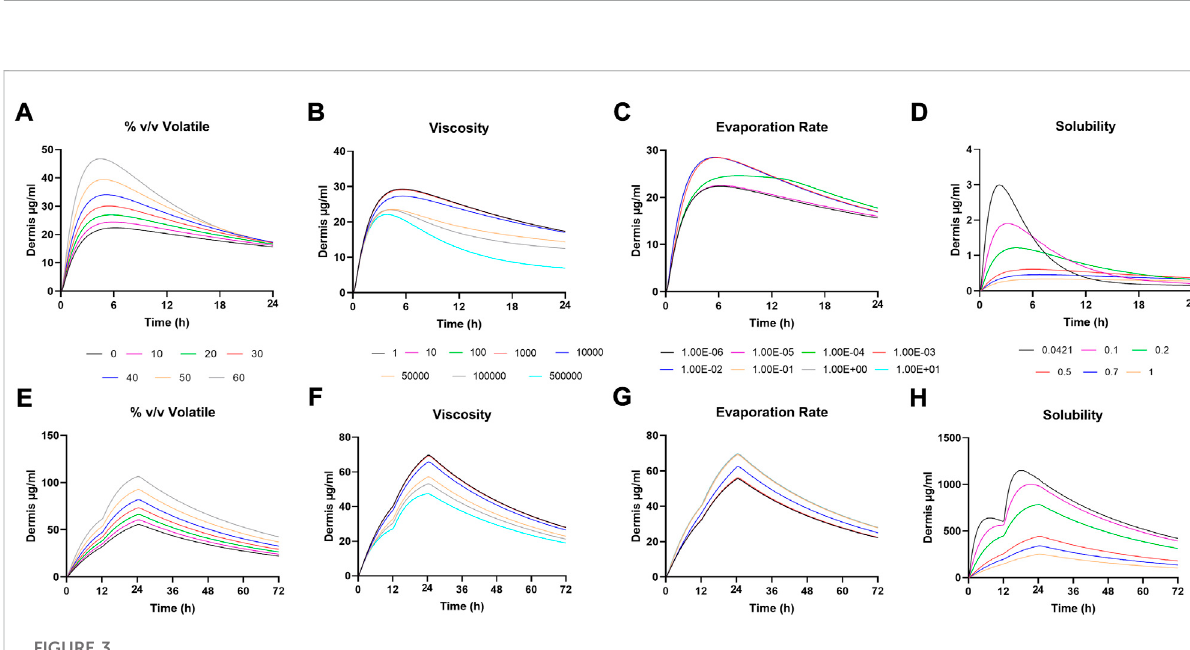
Various formulation-speci fi c parameters were tested for their sensitivity. This